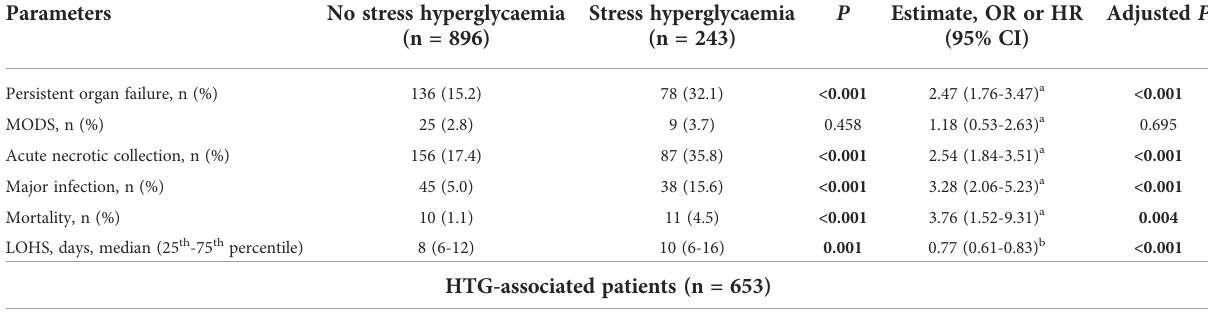
Non-HTG patients (n = 1139)